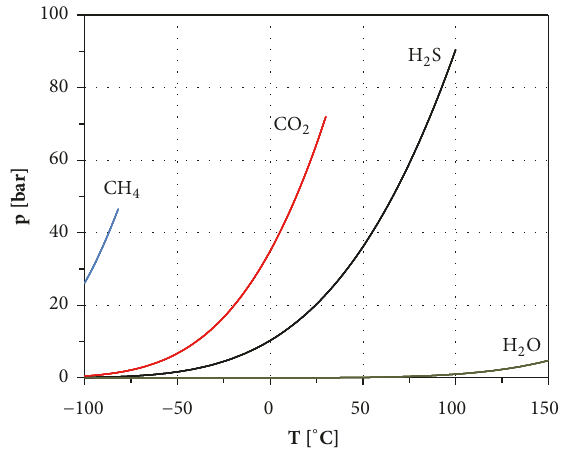
Figure 3: Vapour pressure curves of the gases of interest.